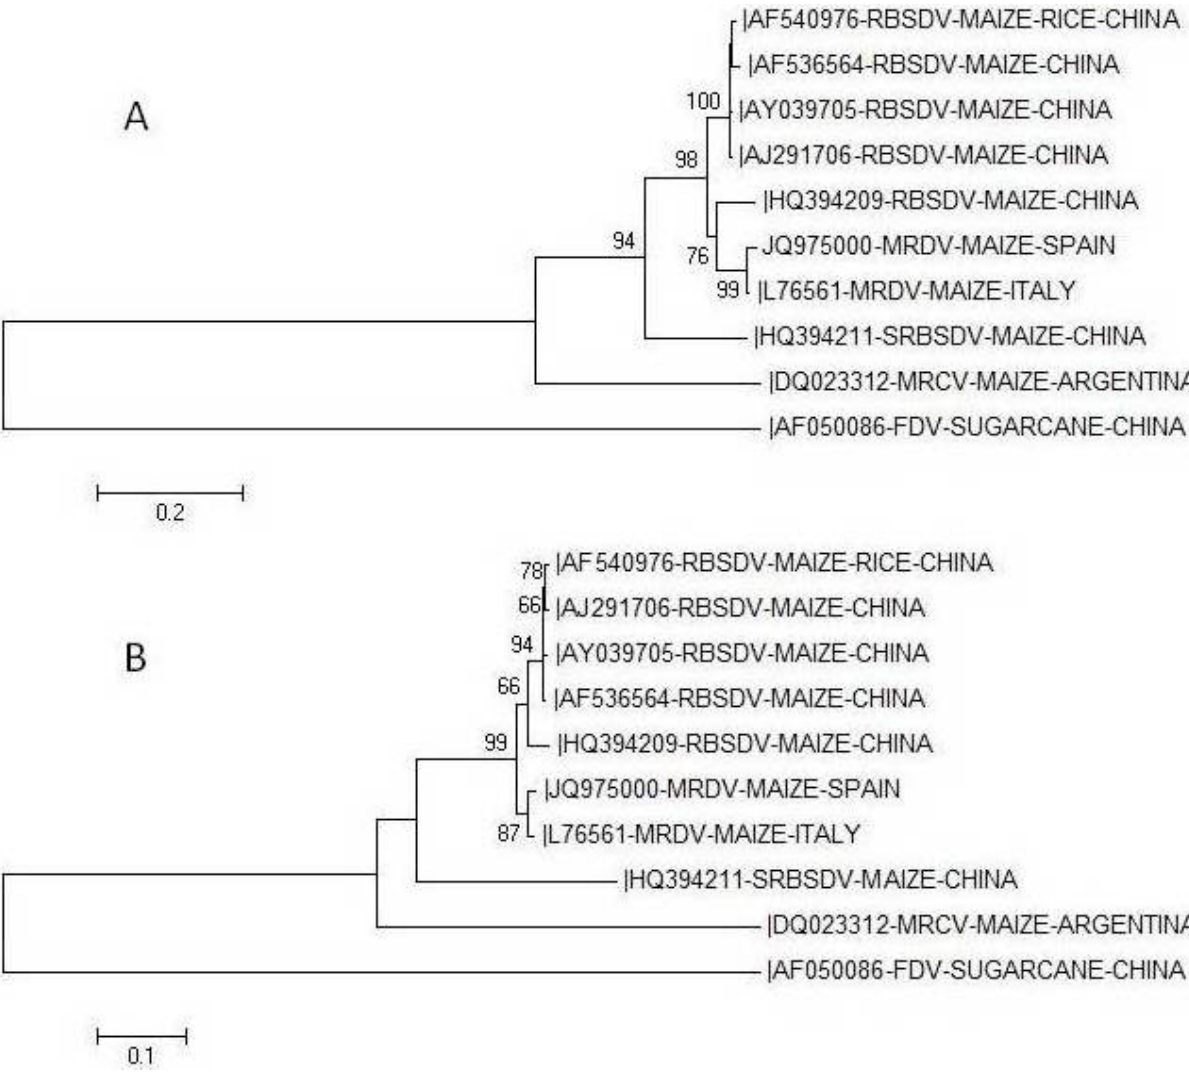
Figure 2. Phylogenetic trees constructed with amino acid sequences of (A) ORF1 and (B) ORF2 of segment 9, from Fijivi- rus that infect maize using the neighbour joining method. The numbers above the branches indicate the frequency of the cluster after bootstrap analysis (1000 replicates). Branches with bootstrap values <50% were collapsed, and only branches with bootstrap values ≥60% are